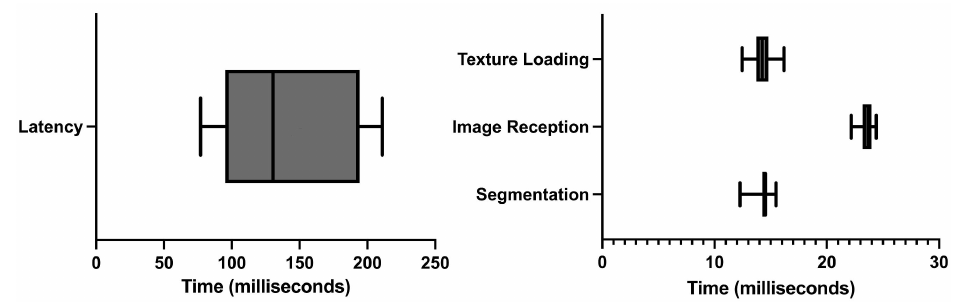
Figure 7. Latency and execution times.